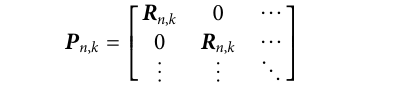
Frontiers in Robotics and AI |